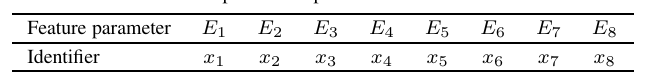
Table 1 The input feature parameters in